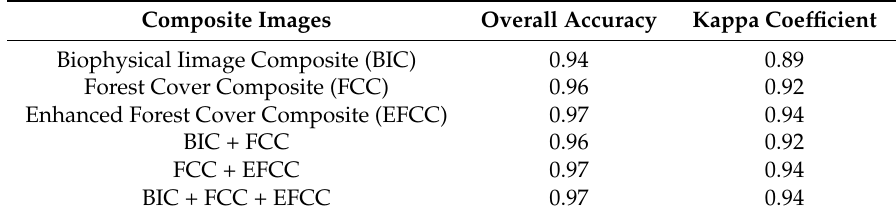
Table 1. Comparison of different composite images using 18,000 reference points for each